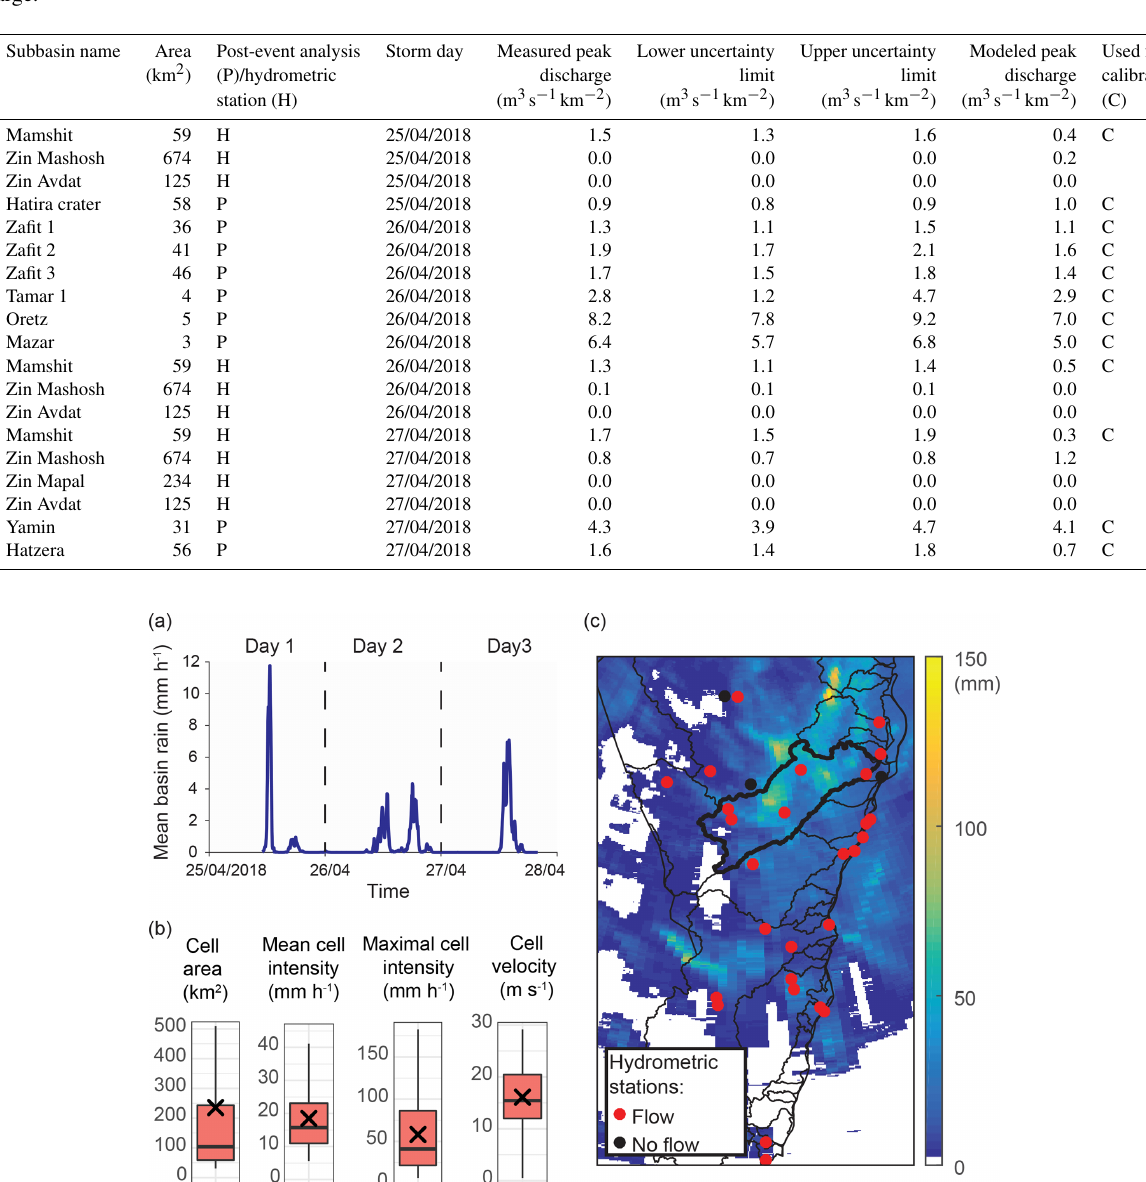
Table 1. Measured and modeled peak discharges for the Zin case study. Uncertainly limits refer to error estimations in the measured peak discharge.